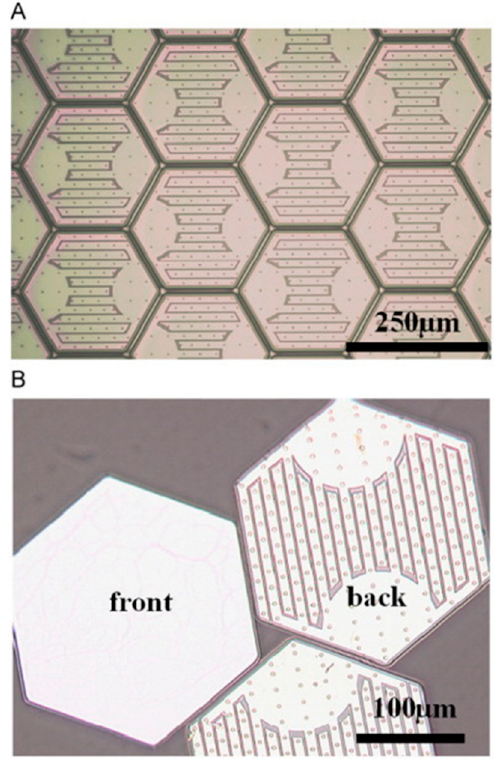
Figure 3. Microscope image of micro-structured PV cells developed by Sandia Laboratories. Reprinted from [98] with permission from Elsevier. ( A ) An array of cells attached to the wafer ( B ) The front and back the cells.